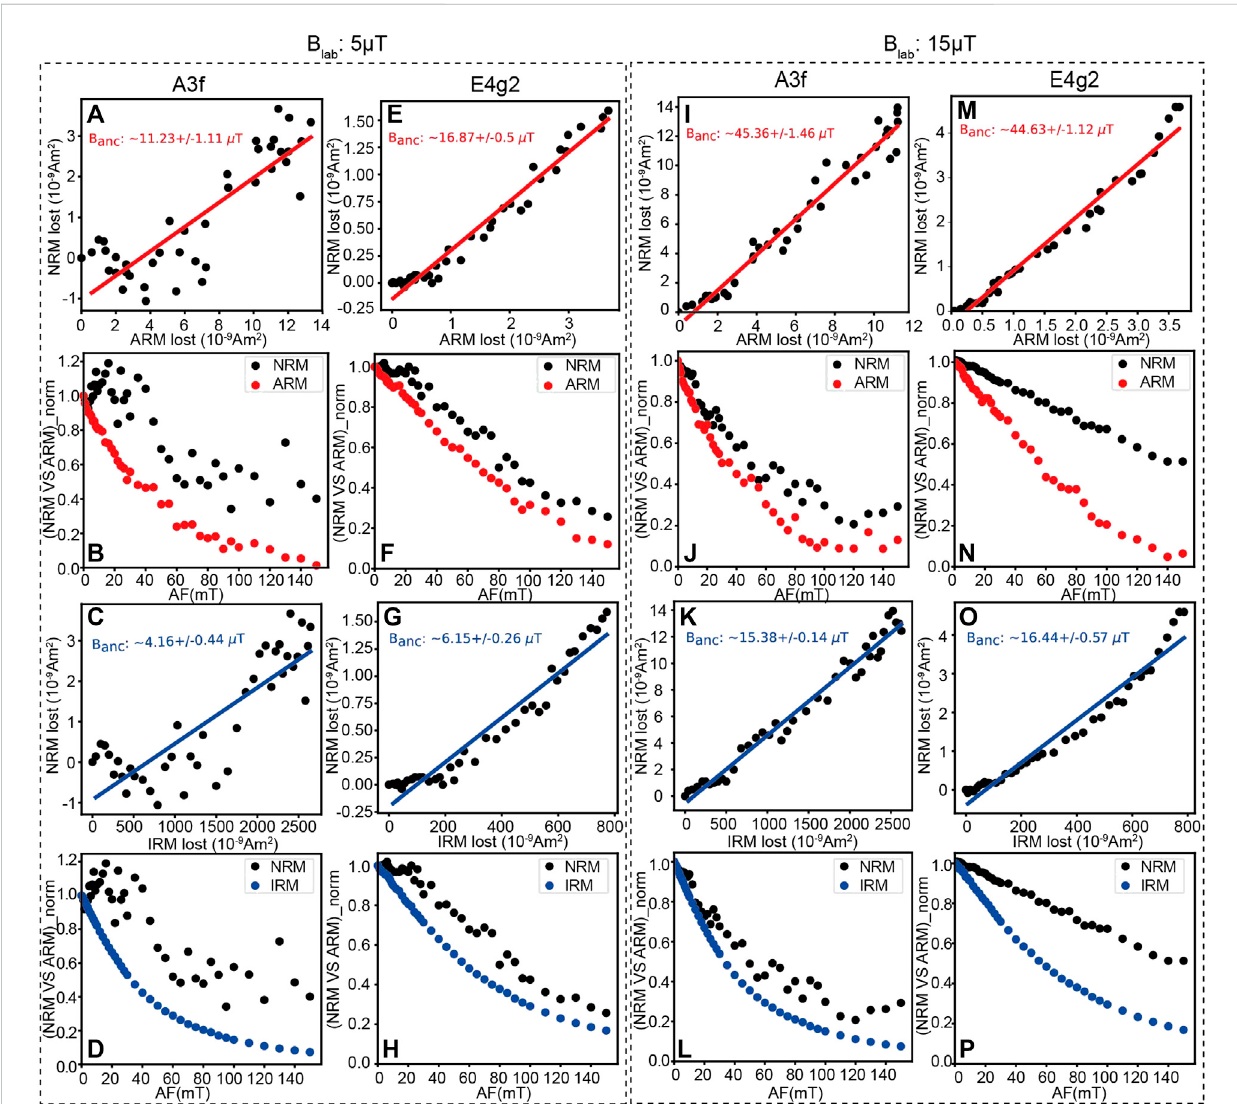
FIGURE 13 Paleointensity results of representative small meteorite specimens from NWA13788A (A – H) and NWA13788E (I – P) . Each column shows the ARM- corrected paleointensity (red), the NRM and ARM decay versus AF steps, the IRM-corrected paleointensity (blue), and the NRM and IRM decay versus AF stepsofeachspecimen.Thelefttwocolumnsareresultswithalab fi eldof5 μ Tandtherighttwocolumnsareresultsofthesametwospecimensbutwith a lab fi eld of 15 μ